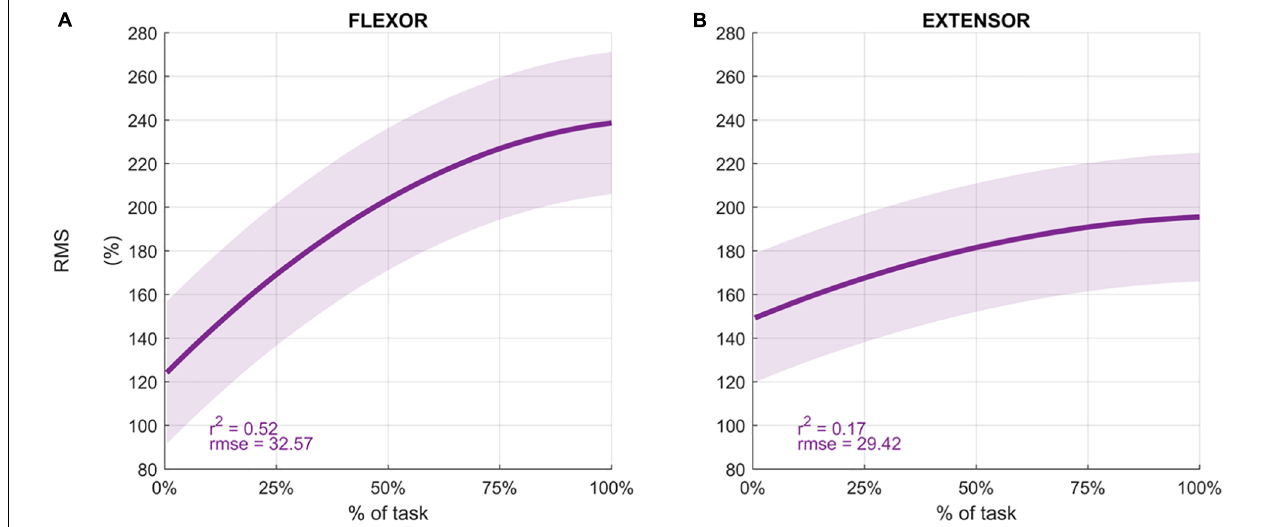
FIGURE 5 | Average Root Mean Square values (%) for the flexor carpi radialis (A) and extensor carpi radialis muscles (B) during the fatigue protocol. RMS was normalized to the initial value of each sequence and averaged across participants to obtain the percentage. Depicted data was fitted with a second order polynomial function (dark purple) and standard error (light purple).